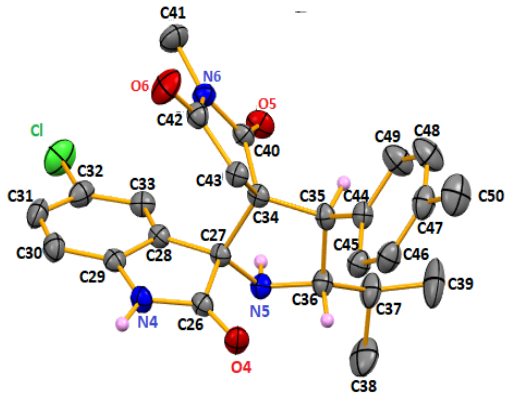
Figure 3. The molecular structure of one of the two independent molecules of 5b , showing the atom-numbering scheme. The displacement ellipsoids drawn at the 50% probability level. Only relevant H atoms are shown for clarity.